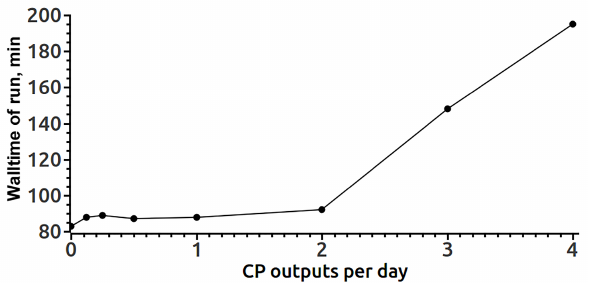
Figure 7. Wall-clock time of an 8-day run of INMIO World Ocean model with 0.1 ◦ resolution vs. frequency of saving solution control